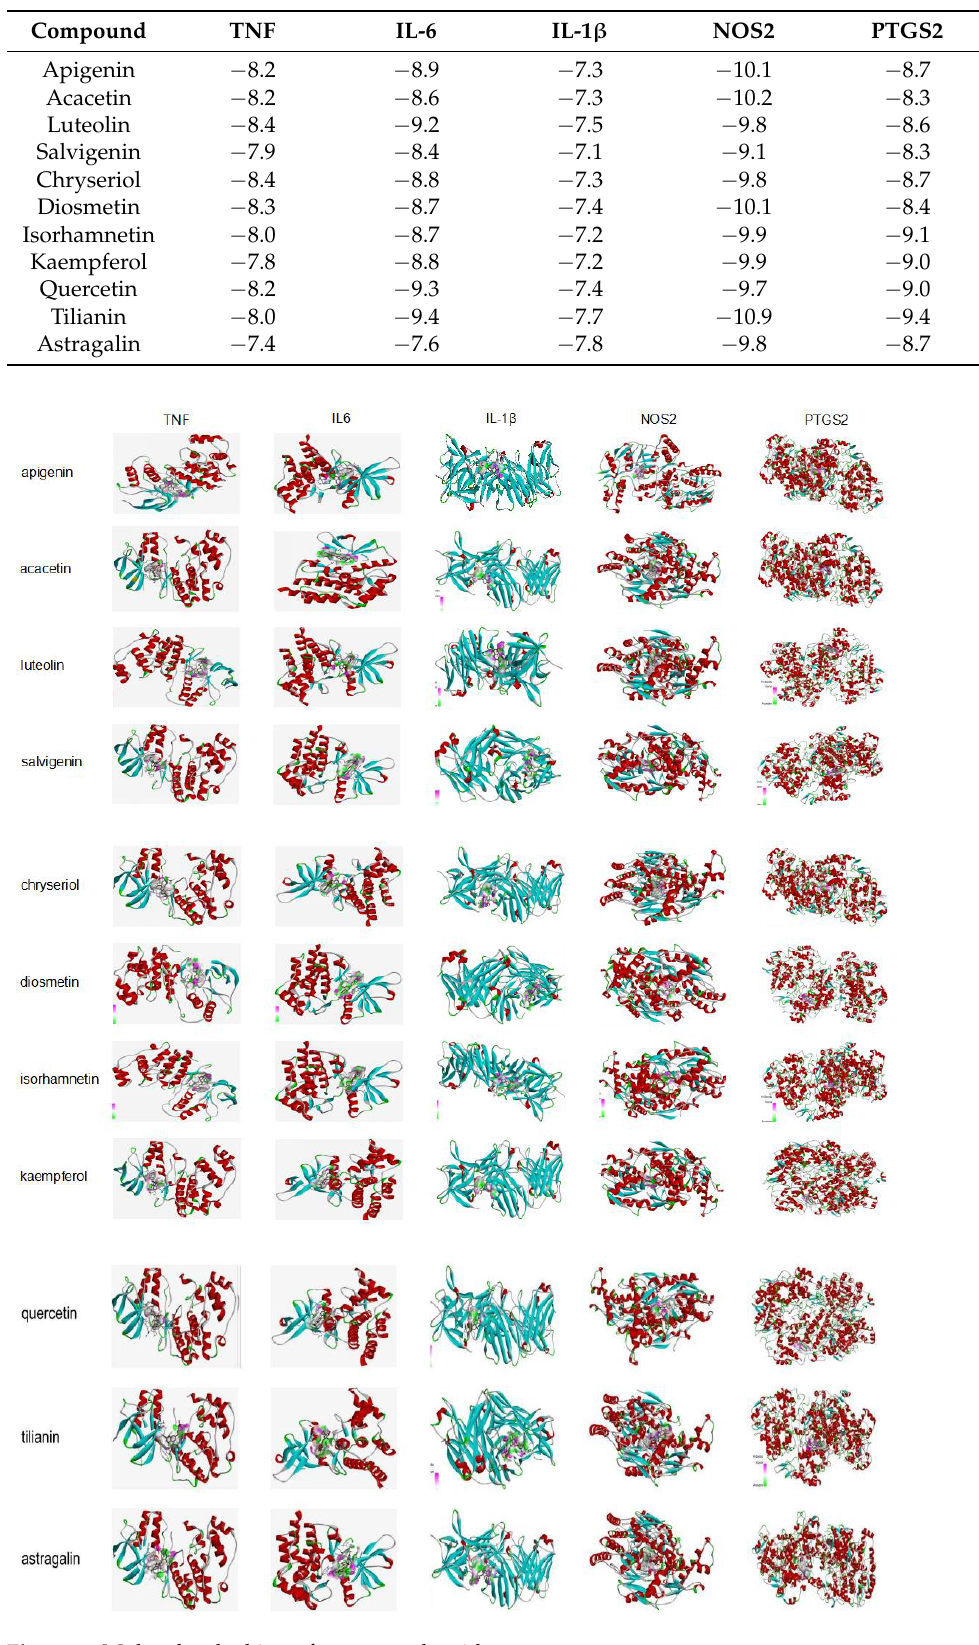
Table 4. Docking scores (kcal/mol) of compound–target docking.